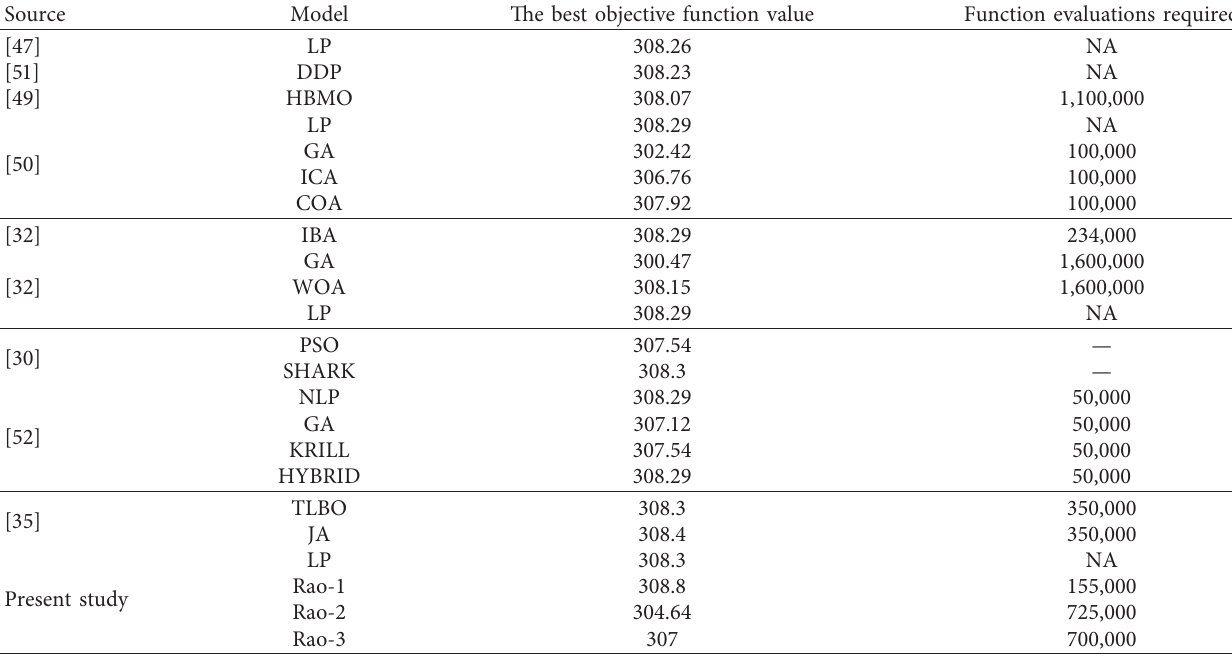
Table 7: The benchmark models and the proposed new algorithm of the current research performance for the CFRO system problem.